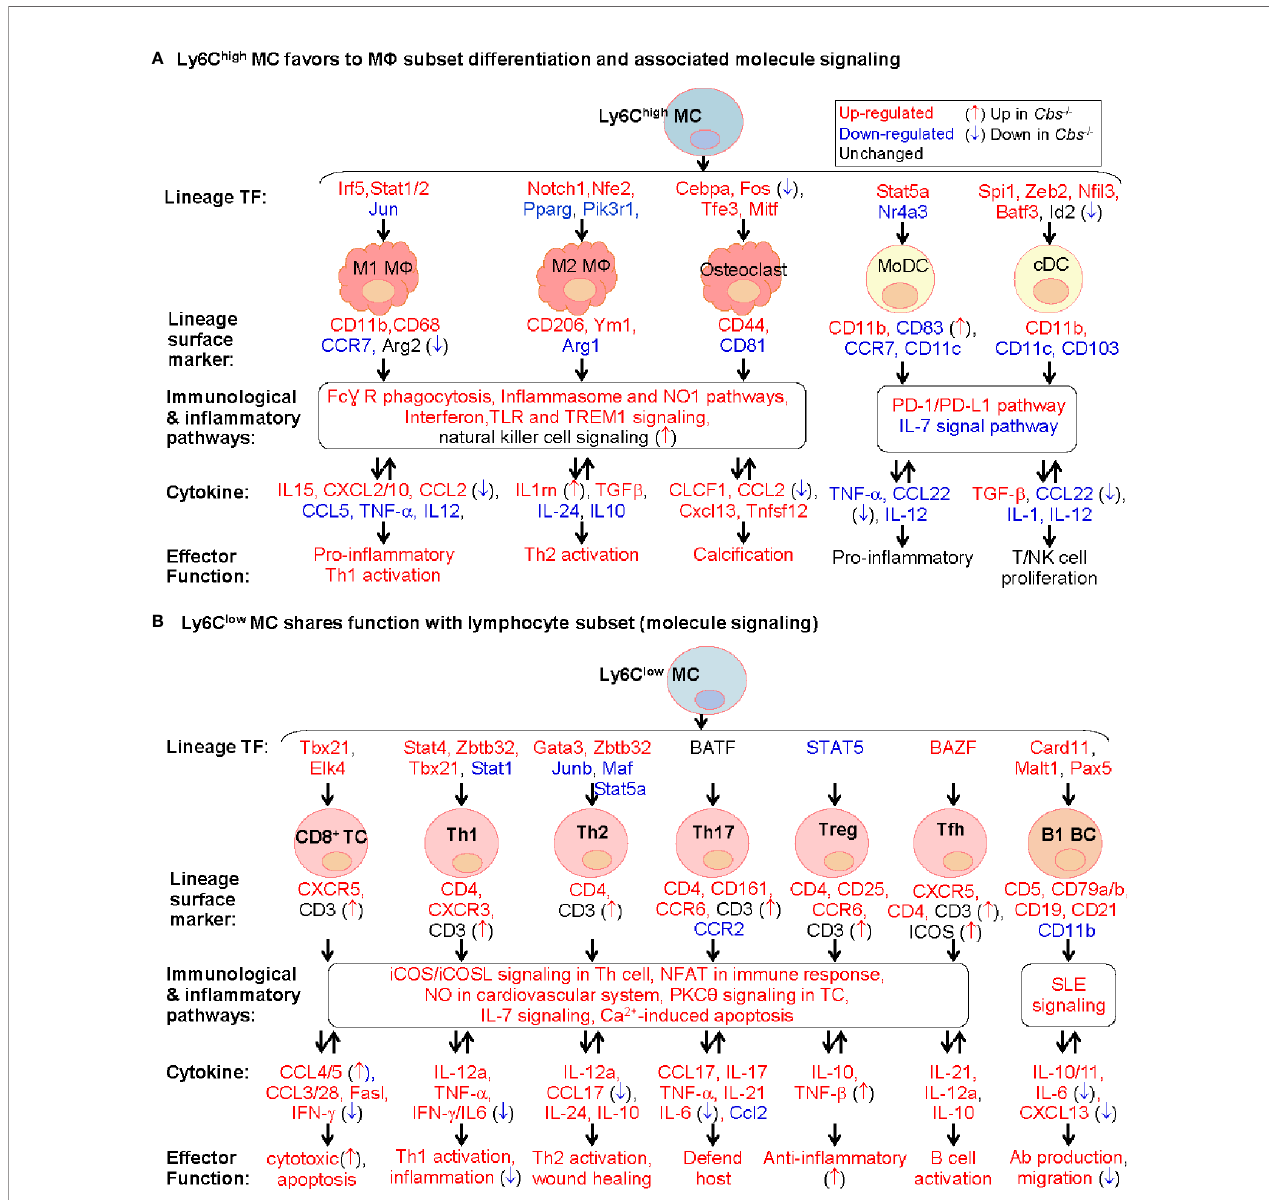
FIGURE 8 | Molecule signaling of Ly6C MC to M F subset differentiation and to lymphocyte subset functional adaptation. We established two models for molecule signaling of MC differentiation based on their preferential expression of lineage signature TF, surface marker and cytokine using information extracted from Figures 3 , 5 , and 7 . (A) Ly6C high MC favors to M F subset differentiation and associated molecule signaling. Ly6C high MC preferentially expressed lineage signature TF genes of M F /DC subsets, suggesting their potential differentiation to M F . The indicated immunological and in fl ammatory pathways lead to various changes of cytokines production, and effector function including T/NK cell proliferation, in fl ammatory response and calci fi cation. Cbs -/- Ly6C high MC exhibited in fl ammatory cytokine production. (B) Ly6C low MC shares function with lymphocyte subset (molecule signaling). Ly6C low MC preferentially expressed lineage signature TF genes of B/T cell subsets, suggesting their potential functional adaptation to lymphocyte subsets. The indicated immunological and in fl ammatory pathways lead to various changes of cytokines attributed to increased T/B cell activation, host defend, wound healing and anti-in fl ammatory responds. Cbs -/- Ly6C low MC exhibited enhance T/B cell activation potential. Expression change and function implication of SDE cytokine genes in Ly6C MC were presented in Supplementary Table 7 . MC, monocyte; DC, dendritic cell; M F , macrophage; TREM1, the triggering receptor expressed on myeloid cells; NK, natural killer, TC, T cell; Th1, T helper 1 cell; Tfh, T follicular helper; BC, B cell, NFAT, Ca 2+ , Calcium; SLE, systemic lupus erythematosus, IL-7, Interleukin 7; NFAT, nuclear factor of activated T-cells; nNOS, neuronal nitric oxide